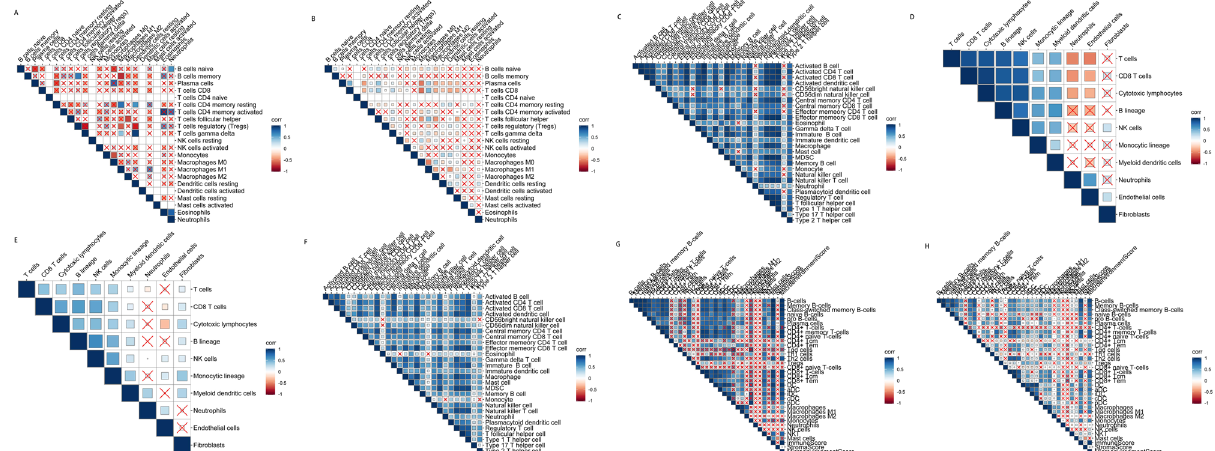
Figure 2. Correlation between immune cells. The correlation between immune cells was assessed using four different methods and is shown in ( A – H ). Blue represents positive correlation and red depicts negative